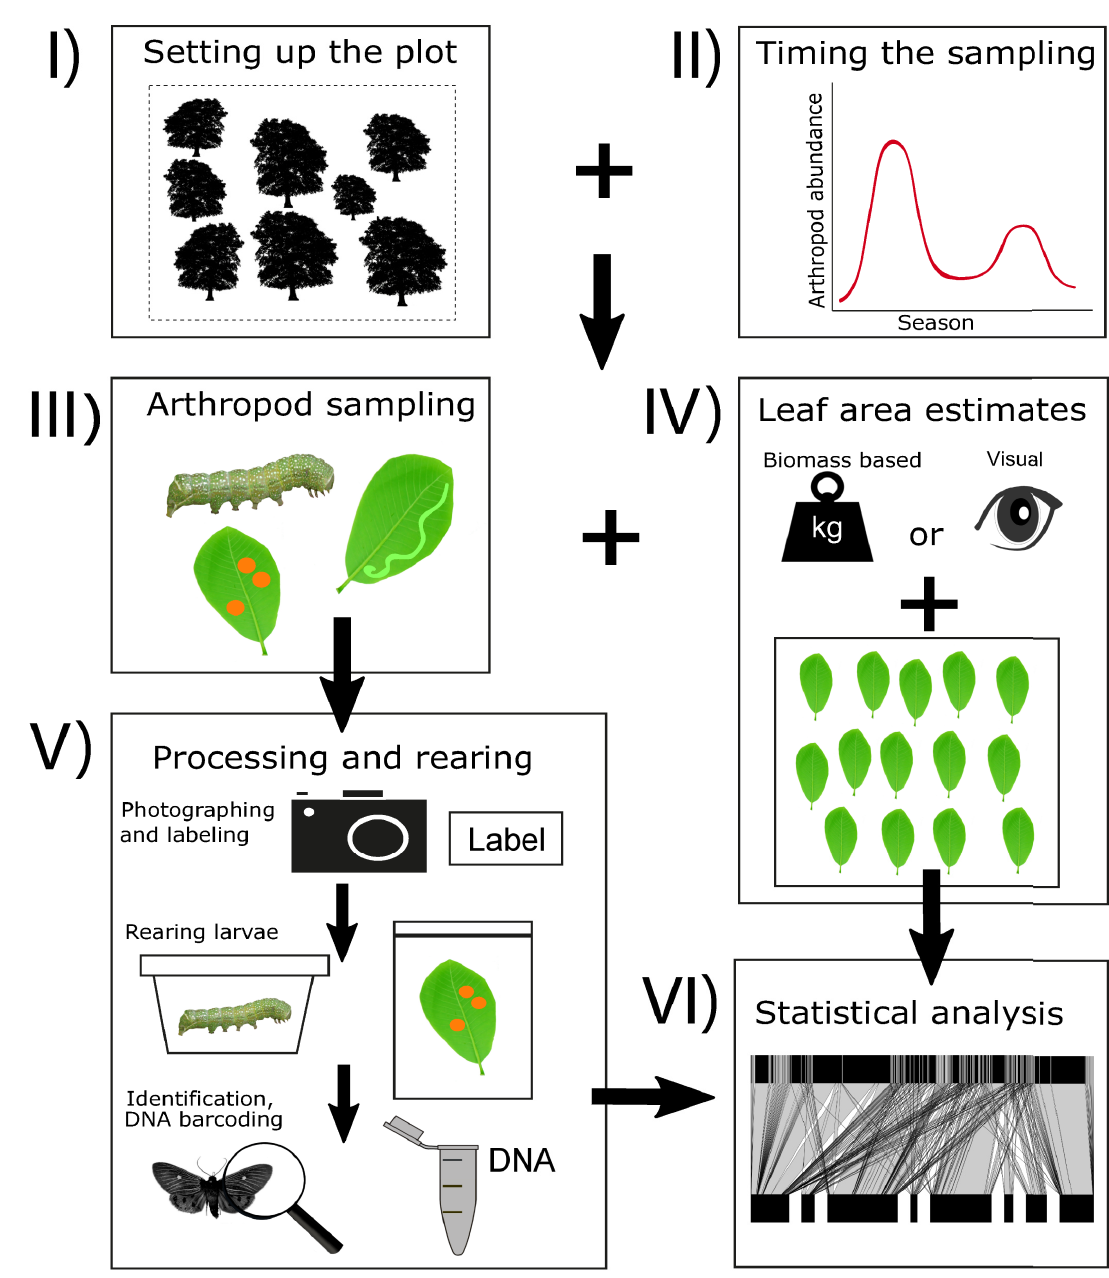
Fig 2. A workflow diagram for the proposed methods. The process starts with setting up the plot (I) and planning the sampling according to seasonality at a given site (II). The field work includes arthropod sampling (III) and estimation of leaf area (IV, including visual or biomass based estimates and processing of leaf frames). Sampled arthropods are then processed (V), which includes the labelling and photographing of morphospecies, rearing, and the sending of material for taxonomic identification or DNA barcoding. Finally, the data are analysed